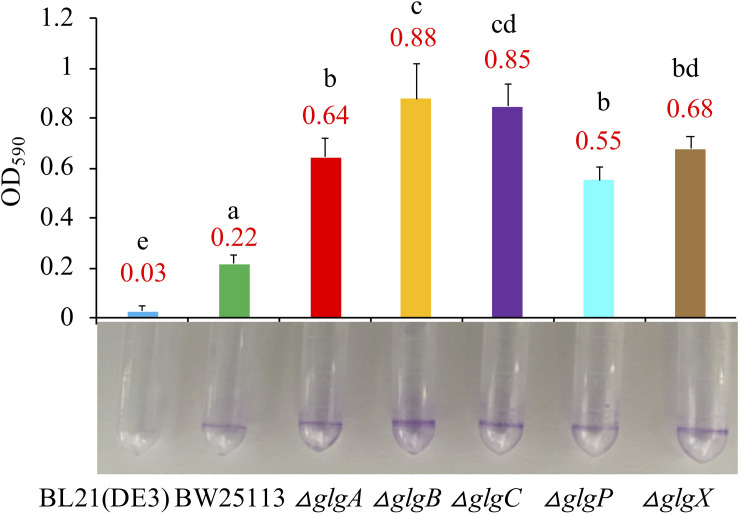
Comparison of biofilm formation abilities of E. coli wild-type strains, BL21(DE3) and BW25113, and five mutated strains, ΔglgA, ΔglgB, ΔglgC, ΔglgP, and ΔglgX in Luria-Bertani broth medium. Biofilm formation abilities in 2 mL plastic round-bottom EP tubes stained with 0.1% crystal violet solution were matched with bar chart that corresponded to mean values and standard errors. Tukey’s HSD test was performed for statistical analysis. Means denoted by a different letter indicated significant differences between groups (P < 0.05).